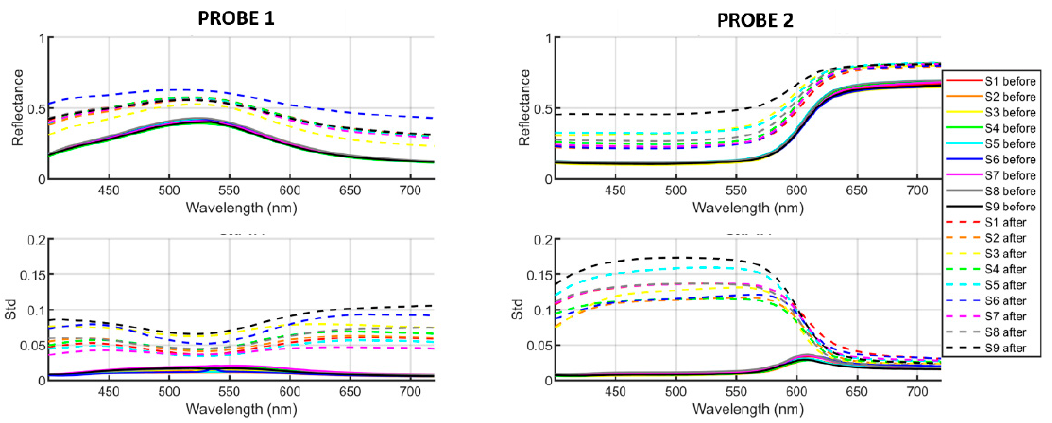
Figure 5. Mean spectral reflectances (top row) and wavelength-wise standard deviations (bottom row) of the 36 samples shown in Figure 4. Left column for probe 1 and right column for probe 2. Continuous lines represent the samples before and dashed lines after the cleaning process.